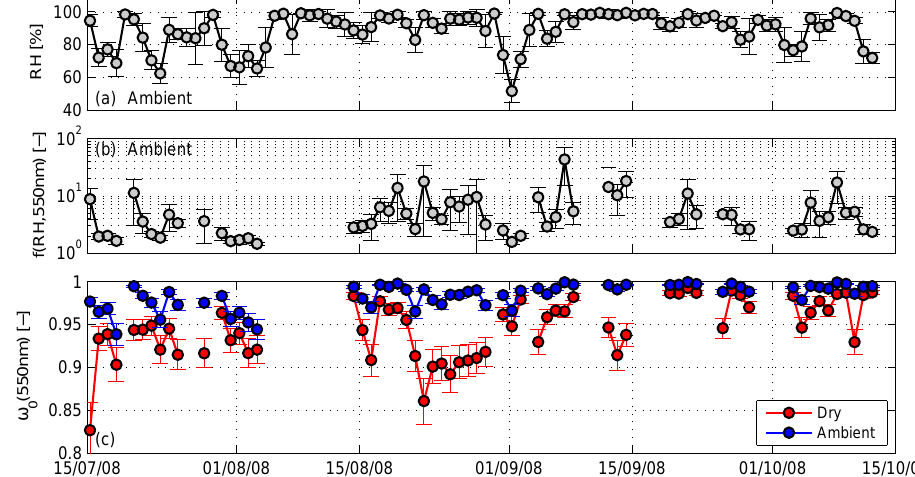
Fig. 10. Single scattering albedo of the measured dry aerosol and recalculated to ambient conditions. (a) : Relative humidity (RH) outside Zeppelin station (error bars denote standard deviation of daily average). (b) : Scattering enhancement factor f ( RH, λ = 550nm) at ambient RH. (c) : Single scattering albedo ω 0 (λ = 550nm) measured at dry conditions (red points) and recalculated to ambient RH (blue points, daily averages, error bars are determined by error